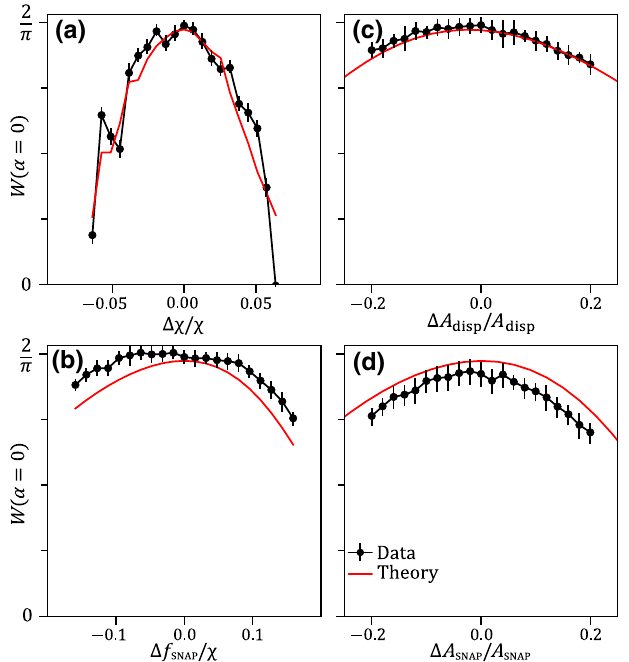
FIG. 4. Sensitivity of the displacement-SNAP sequence to dif- ferent calibration parameters. Wigner function at the origin for a two-photon Fock state versus the (a) dispersive shift χ , (b) modulation frequency of SNAP gates f SNAP , (c) amplitude of the displacement pulses A disp , and (d) amplitude of the SNAP pulses A SNAP . Dots denote experiment and the solid line denotes theory. The error bars represent one standard deviation of 20 repetitions of each experimental